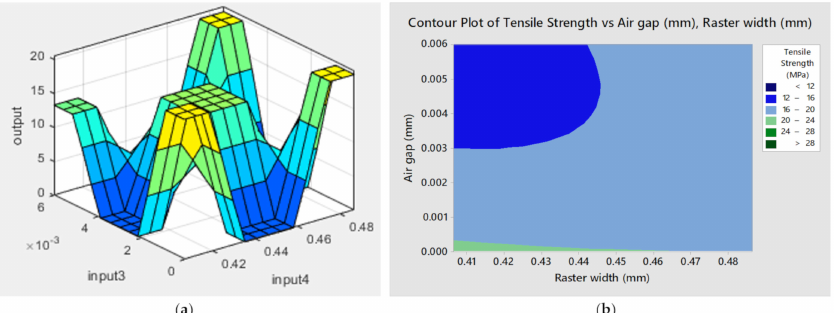
Figure 7. 3D plot ( a ) and contour plot ( b ) of tensile strength vs. air gap and raster width.